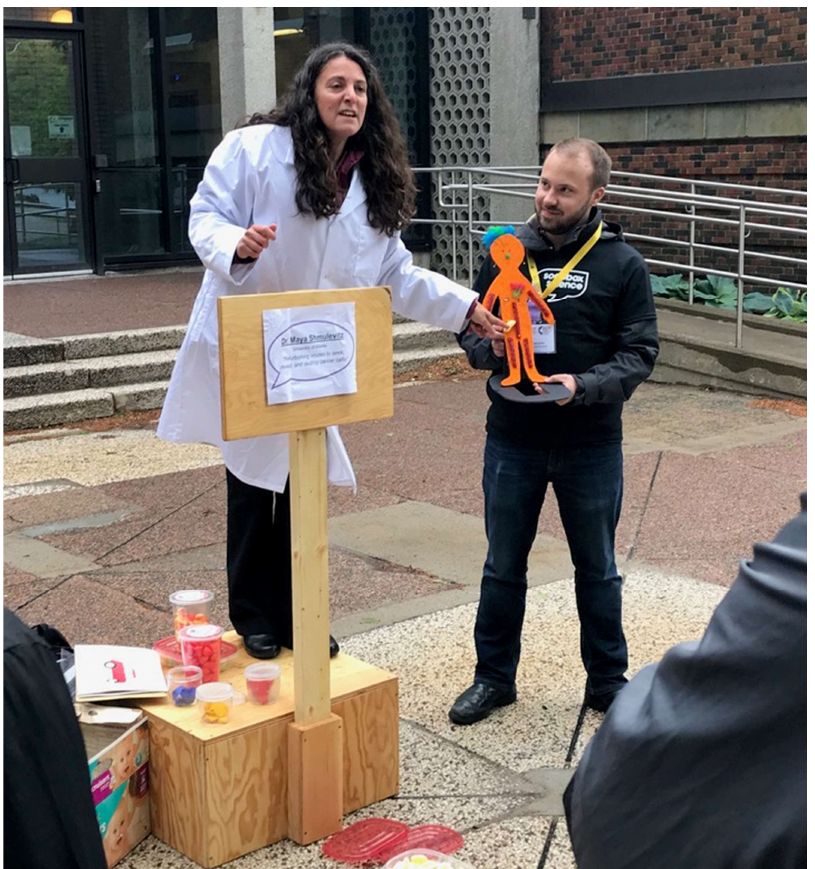
Figure 2. Soapbox Science preview event. Soapbox Science is a science communication event in which female scientists stand on “soapboxes” (see above) and discuss their research with the lay public using simple props. These events are intended to boost the visibility of female scientists and inspire the next generation. In this photo, Dr. Maya Shmulevitz (University of Alberta) is explaining her research program using art supplies and candy; she is illustrating how scientists can transform a virus that CAUSES disease, into a virus that TREATS disease. Volunteer Lucas Jarche (Dalhousie University) is seen here holding a “typical healthy human”, which is composed of many human organs that each have their own unique features (e.g., bones are licorice, heart is a cherry gummy). The audience was asked to make a virus that targets a specific organ, using the corresponding candy. For example, a virus that homes to the heart would have evolved to recognize specific features of the heart/cherry gummy. Additional features of viruses were then added; For example, viruses that cause disease often interfere with immune responses, so candies were added to represent these attributes. Following a discussion of the features of cancer, the audience were instructed to modify their candy viruses so that they will target cancer cells rather than their natural host cells.